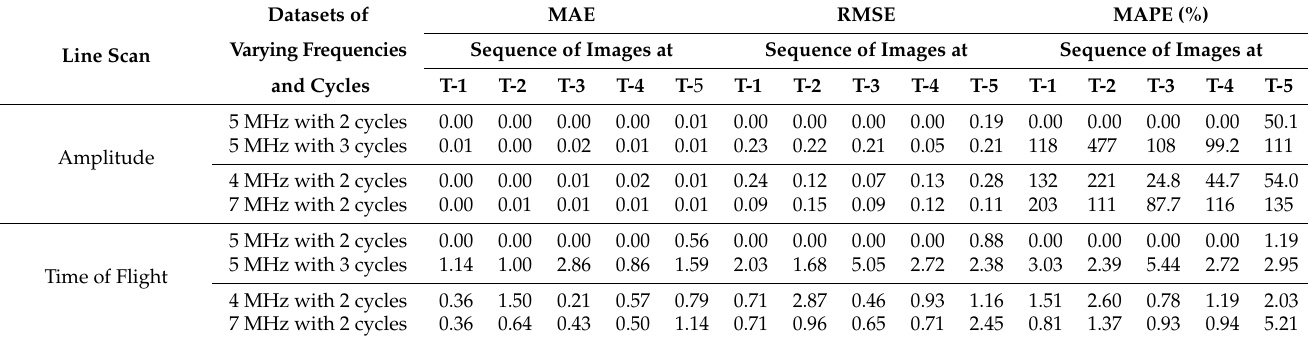
Figure 11. Line scans of reflected wave propagation with a varying number of cycles: The SDL model predicted simulation with FE simulation to examine quantitatively; the displacement values are extracted at x = 15 mm and y = 0 to 40 mm for different time instances from Figure 10. ( a ) Represents the line scans are extracted from Figure 10a for two cycles, and ( b ) illustrates the line scans are extracted from Figure 10b, for three cycles in the rectangular domain. Table 3. Reflection wave propagation on the rectangular domain with varying frequencies and cycles: The SDL model line scan amplitude and time of flight (TOF) are compared with FE using MAE, RMSE, and MAPE methods at different time instances, as shown in Figures 9 and